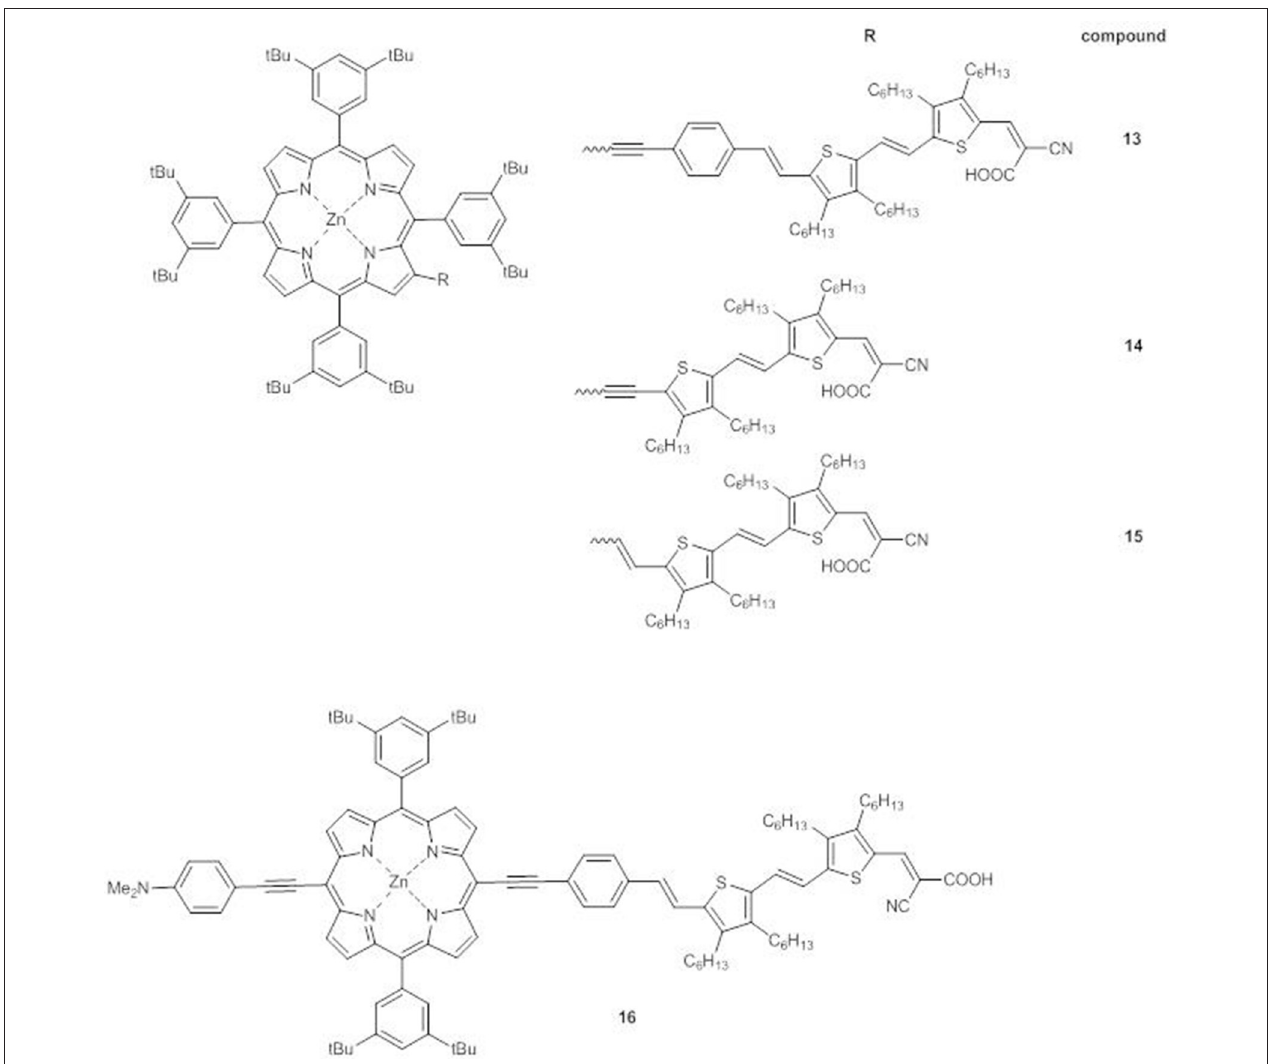
FIGURE 7 | A 4 β -pyrrolic Zn II porphyrins 13-15 and trans -A 2 BC push-pull Zn II porphyrin 16